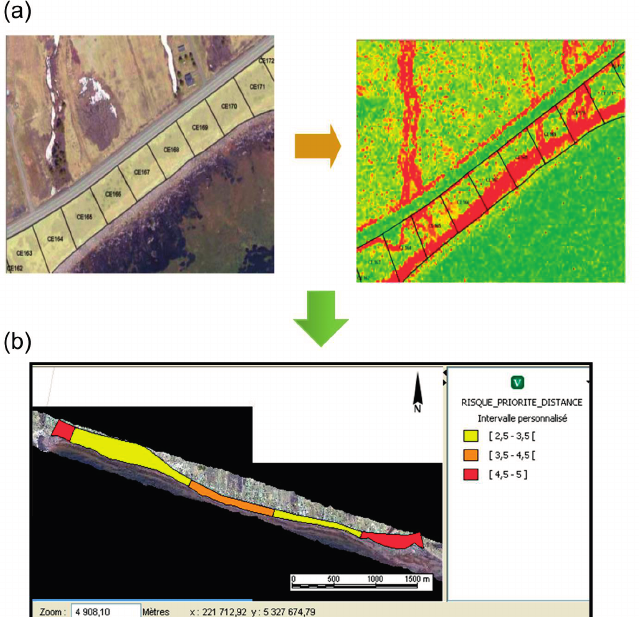
Figure 1. An example of coastal erosion risk representation: ( a ) tessellate the region into well-defined polygons, ( b ) spatial representation of risk zones by aggregating a series of these polygons with the same level of risk